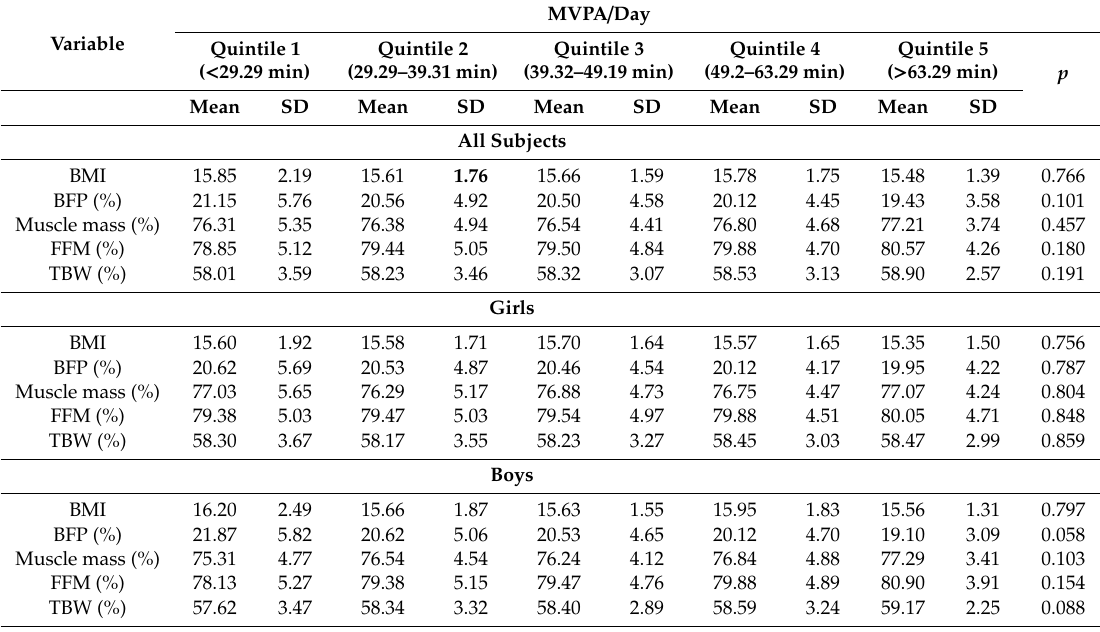
Table 6. Body composition indices according to the quintiles of MVPA.